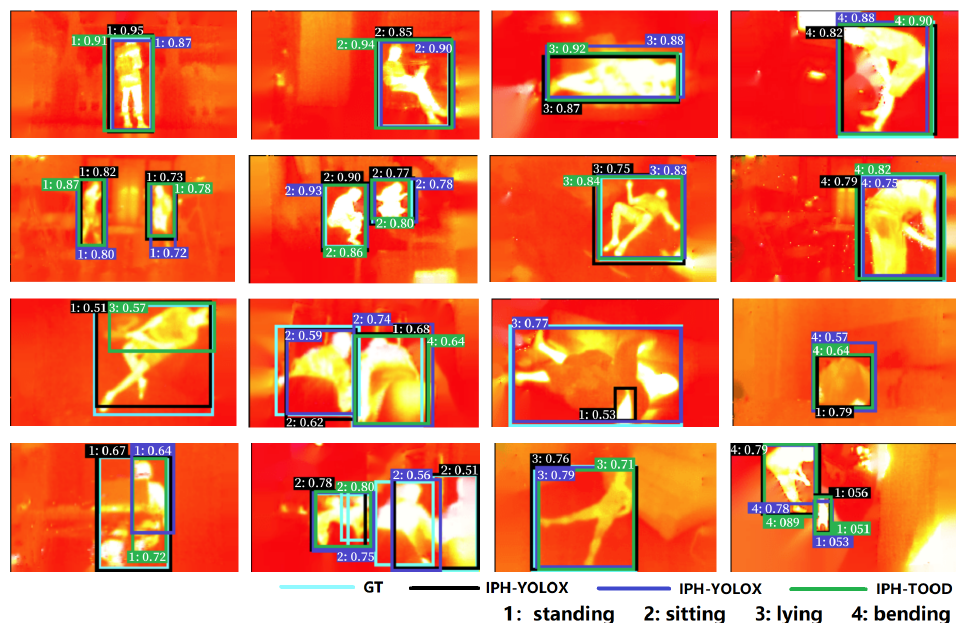
Figure 8. Qualitative evaluation of 16 samples in IPHPDT. The first two rows show examples of our proposed three detectors correctly predicting human postures. The last two rows show examples that our proposed three detectors fail to correctly predict human postures. Note that the number before the colon indicates the predicted posture, i.e., 1, 2, 3, and 4 represent standing, sitting, lying, and bending, respectively. GT stands for ground